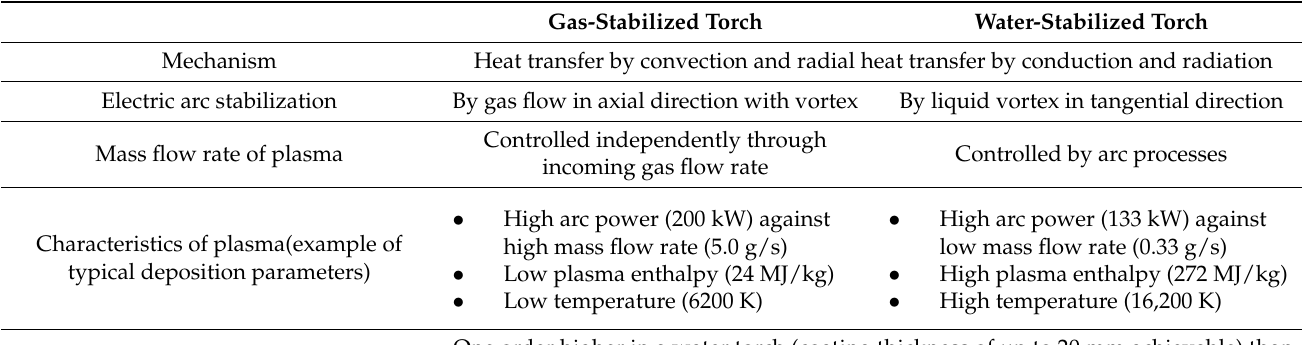
Table 1. Comparison of plasma arc techniques between a gas torch and a water